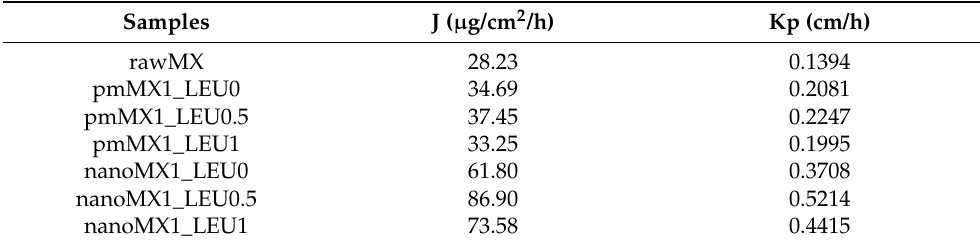
Figure 5. In vitro diffusion results of the API (rawMX), the physical mixtures (pmMX1_LEU0, pmMX1_LEU0.5, and pmMX1_LEU1), and the prepared samples (nanoMX1_LEU0, nanoMX1_LEU0.5, and nanoMX1_LEU1). SD < ±2% (n = 3 independent measurements). Table 8. In vitro permeability results of the samples.